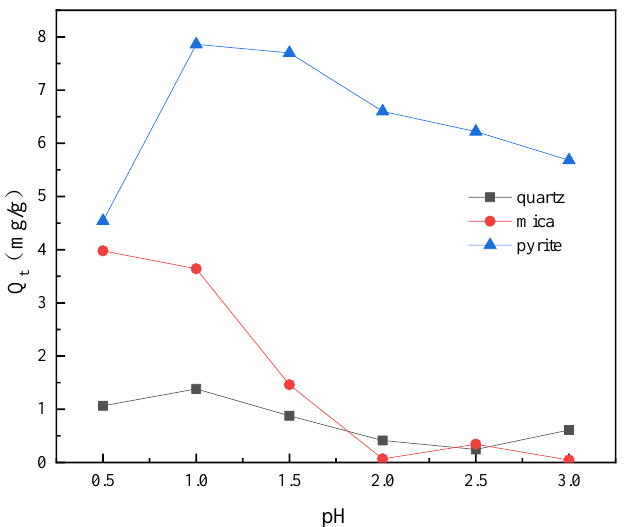
Figure 2. Effect of pH values on the adsorption of thiourea on quartz, mica, and pyrite.